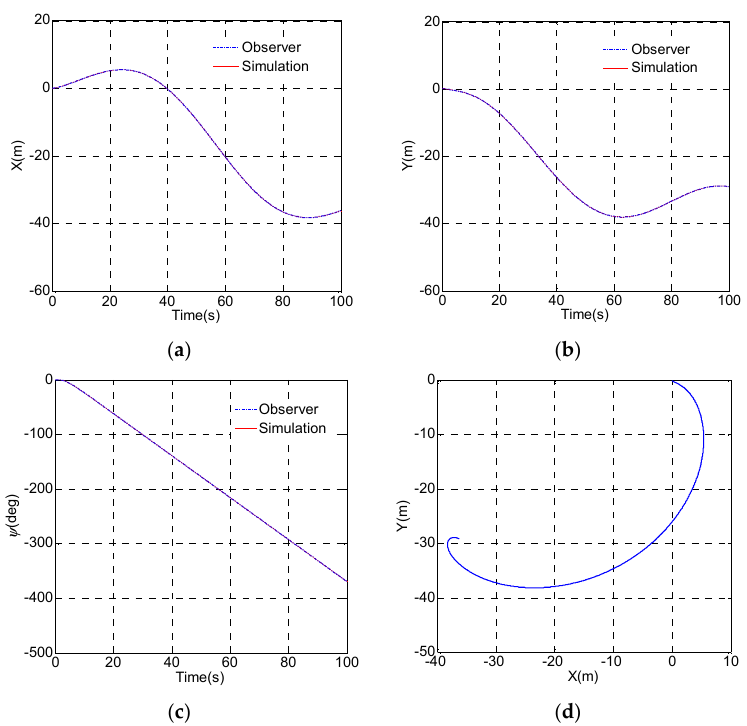
Figure 11. Observed results of position and heading of ROV: ( a ) X; ( b ) Y; ( c ) heading; ( d ) trajectory of ROV in the XY plane.